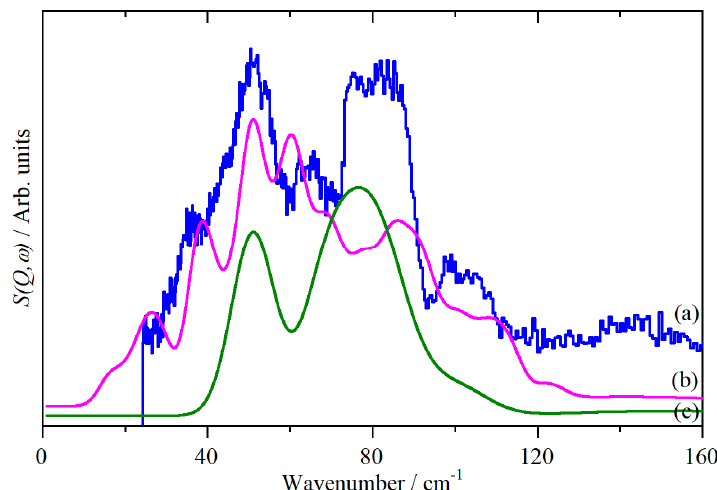
Figure 4. INS spectra of solid CS 2 in the lattice mode region. (a) Observed, (b) generated from a periodic-DFT calculation for the complete Brillouin zone, and (c) as (b) but for the Γ -point only.